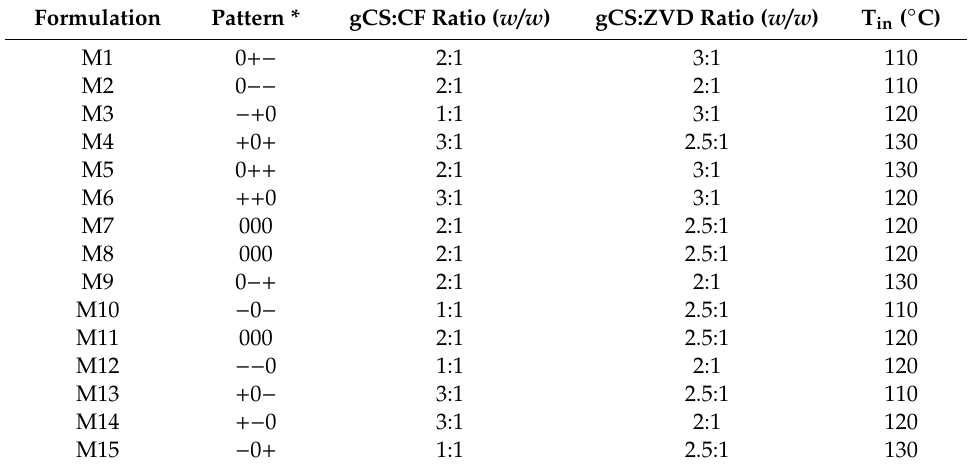
(Table 1). A placebo formulation with 2% gCS concentration and a gCS:CF ratio at 2:1 prepared at ◦ 130 C was obtained as an additional control. Table 1. The studied variables and certain level settings in the applied Box–Behnken